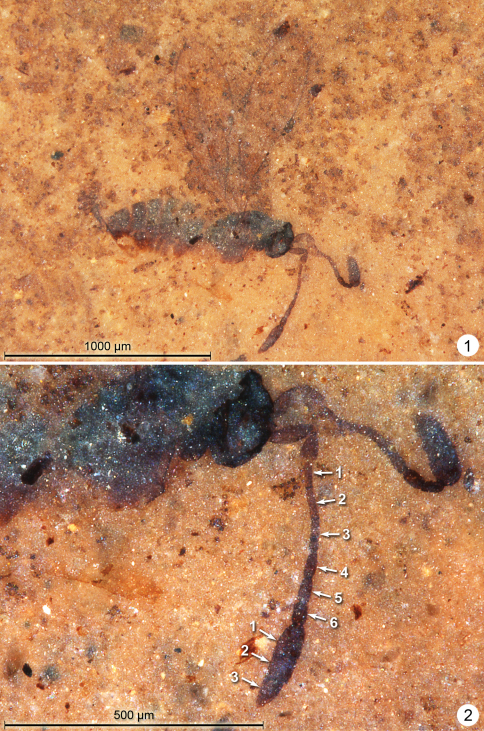
Eoeustochus kishenehn, holotype 1 habitus lateral 2 mesosoma, head, antennae.